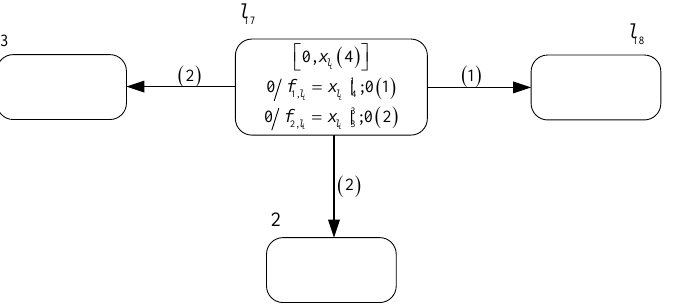
Figure 13. The ADD-ADD model simulating consecutive ADD-ADD instructions l 17 : ( ADD ( 2 ) , l 21 ) and l 21 : ( ADD ( 3 ) , l 18 ) .